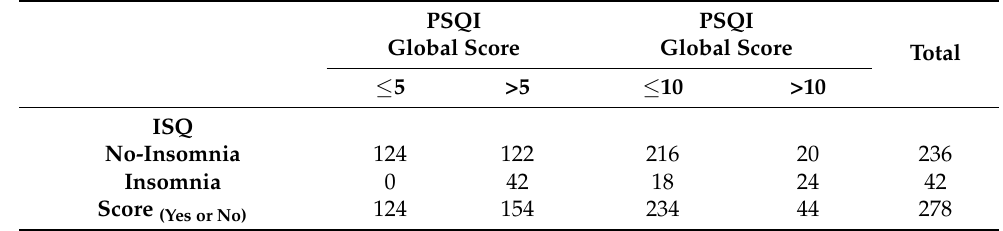
Table 2. Cross-tabulations between PSQI global score (cut-off of >5 and >10) and ISQ (T0) classifica- tions of subjects (No-Insomnia and Insomnia).